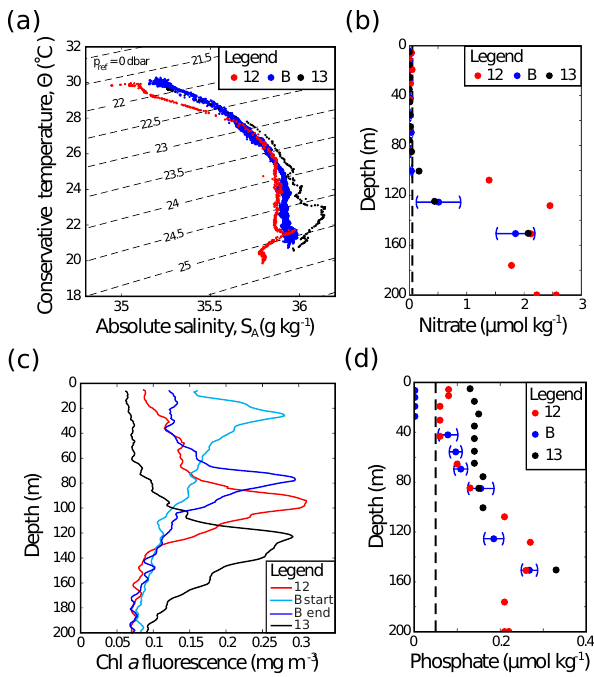
Figure 4. Stations SD12, LDB, and SD13 CTD and bottle data. (a) (cid:50) – S A diagram, (b) NO 3 , (c) chl a , and (d) PO 4 concentrations. SD12 data are shown in red, LDB in blue, and SD13 in black. Quan- titative thresholds for NO 3 and PO 4 are shown by black dashed lines, and any observed values below this threshold are set to 0. The 95% confidence intervals are included for the LDB nutrient